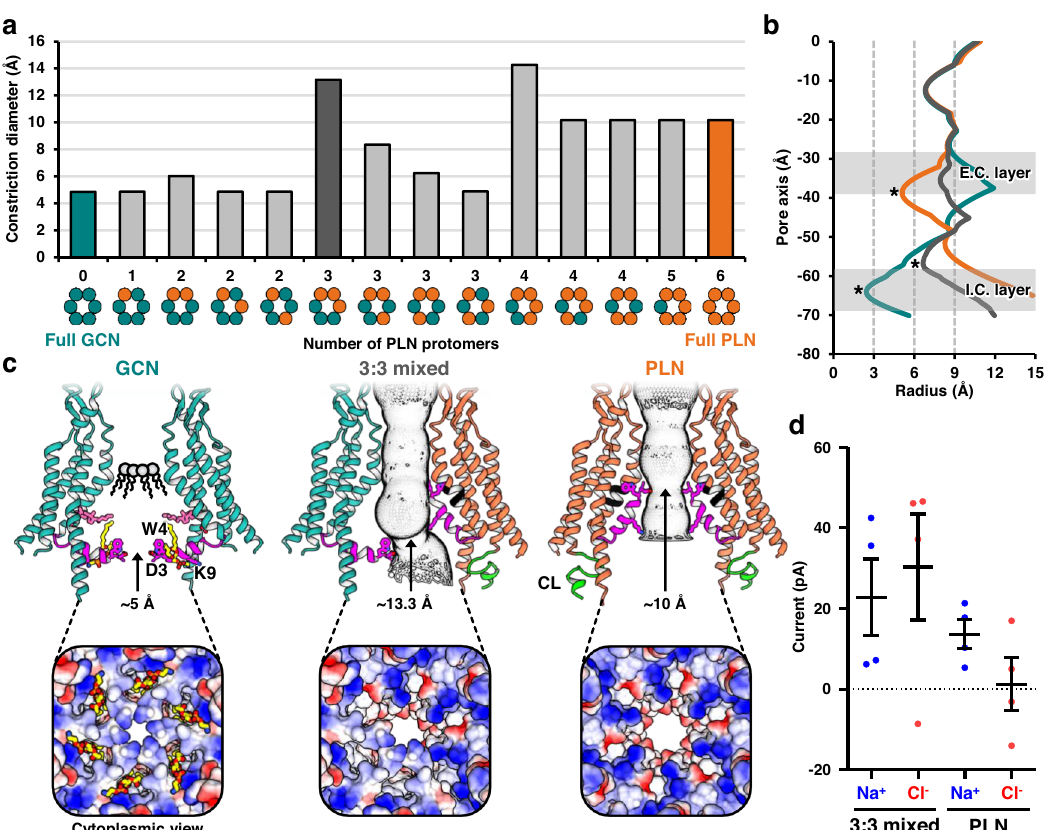
Fig. 7 | Changes in the pore properties during the GCN-to-PLN conversion of individual protomers. a Constriction diameters of various hemichannel regions with possible arrangements of the PLN protomers. b Comparisons among the solvent-accessible poreradiichanging along the pore pathways of GCN, 3:3mixed, andPLNhemichannelregionsaredepicted.Poreconstrictionsitesareindicatedby asterisks. Extracellular layer (E.C. layer) and intracellular layer (I.C. layer) of pore- occluding lipids are indicated. c Comparisons among GCN, 3:3 mixed, and PLN GJIChs are depicted with pore pathways (top). For clarity, only two protomers